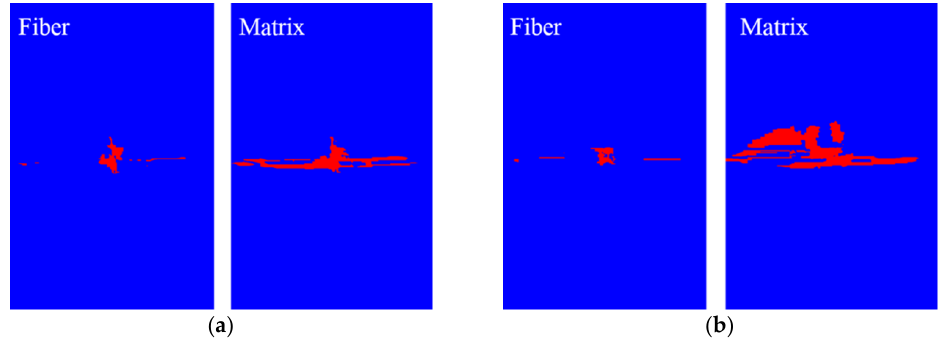
Figure 9. Intra-laminar failure propagation. ( a ) Intra-laminar failure of the 7th ply. ( b ) Intra-laminar failure of the 18th ply.